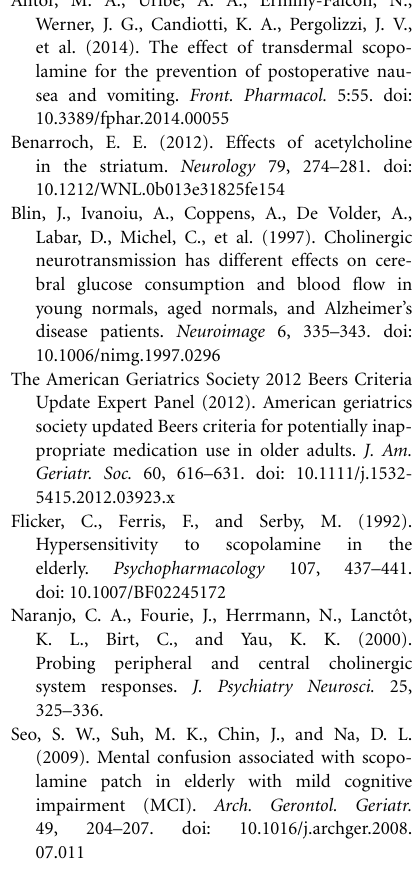
of free scopolamine; detectable